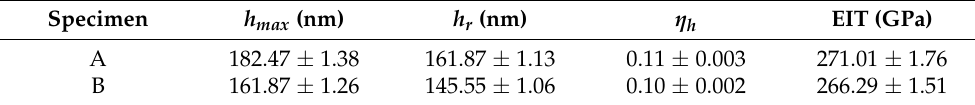
Table 4. Indentation parameters derived from the load-displacement curve in Figure 3.